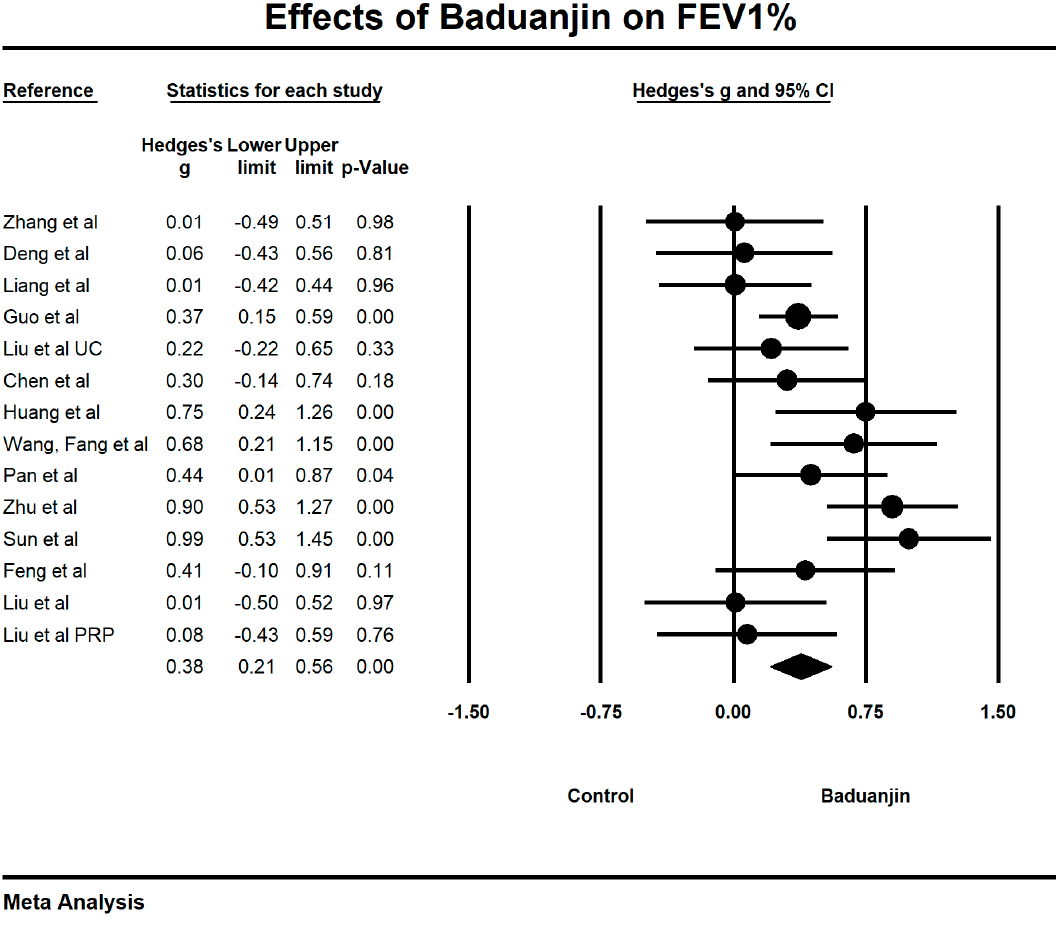
Figure 7. Effects of Baduanjin on FEV1% (PRP = conventional-pulmonary rehabilitation programs; UC = usual care).